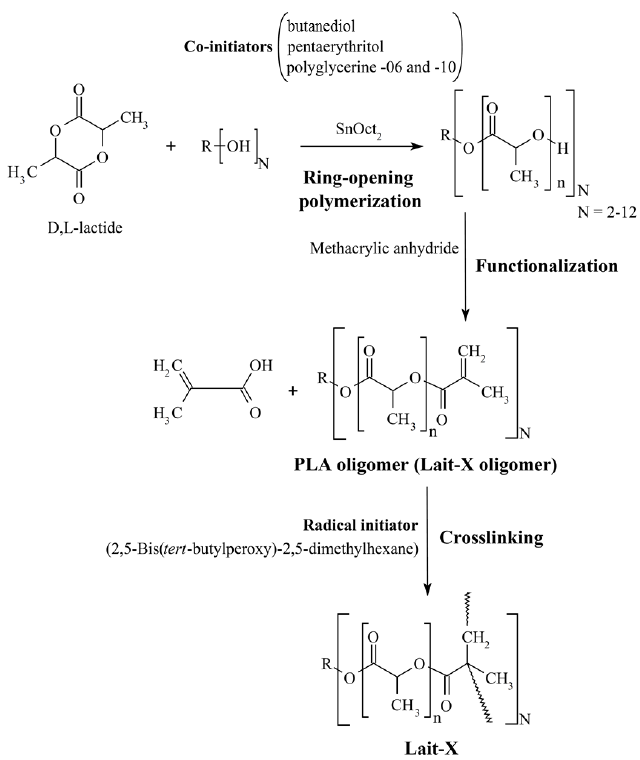
Figure 13. Scheme of synthesis of crosslinked polylactide